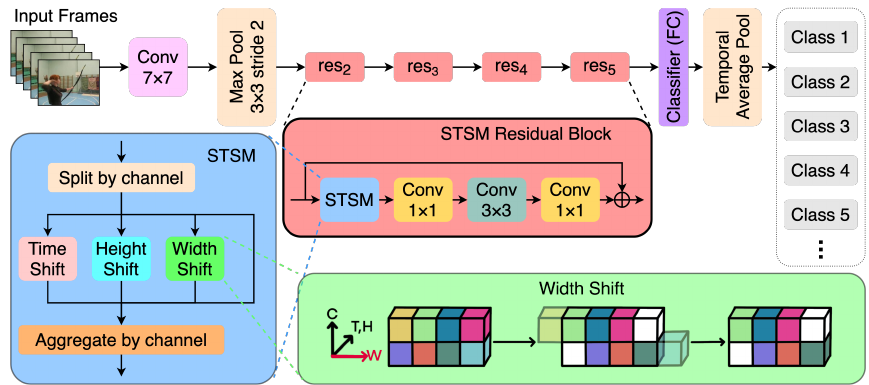
Figure 2. Network structure diagram after embedding STSM in ResNet-50. The convolutions are all 2D spatial convolutions, the first pooling layer is spatial max pooling, and the last pooling layer is an average time pooling. For simplicity, we did not draw the batch normalization layer and the activation function Relu in the